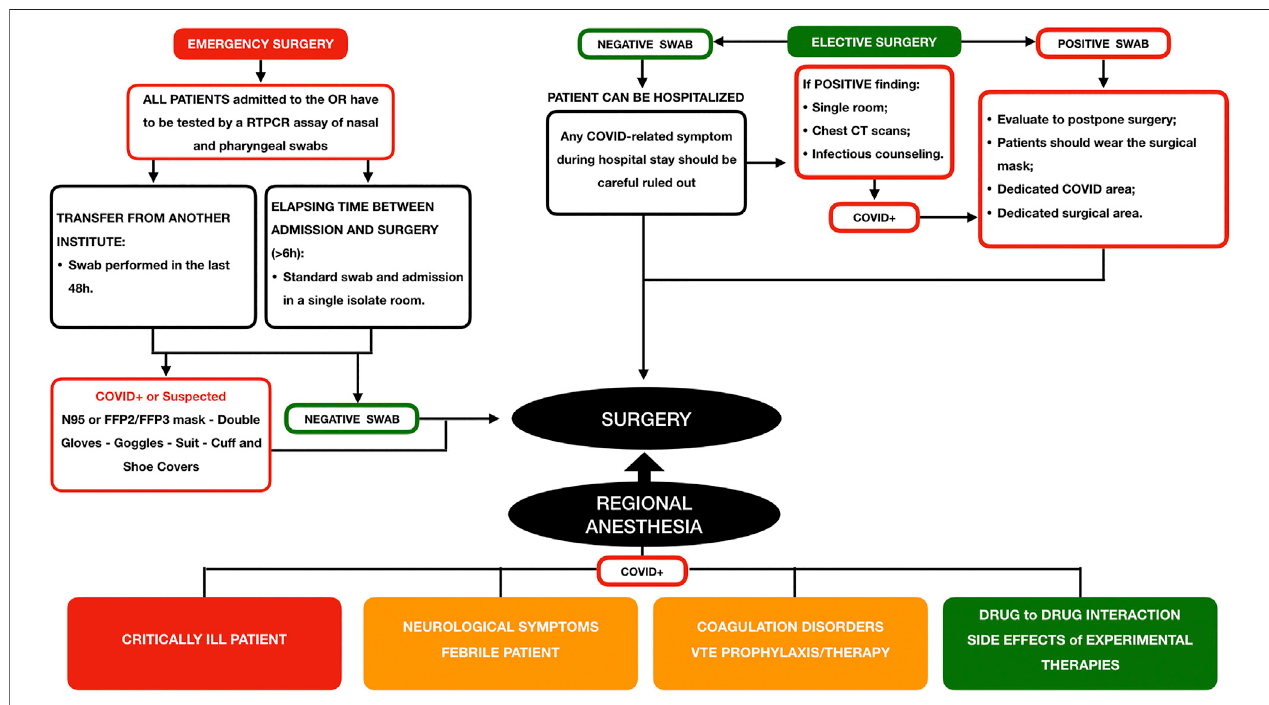
FIGURE 1 | Phase two of the COVID-19 pandemic: surgical patient ’ s management protocol and the role of regional anesthesia (adapted by “ ASST Grande Ospedale Metropolitano ” . Niguarda Hospital, https://accessoweb.ospedaleniguarda.it:11050/img/upload/ fi les/2836_attivit__chirurigca.pdf).